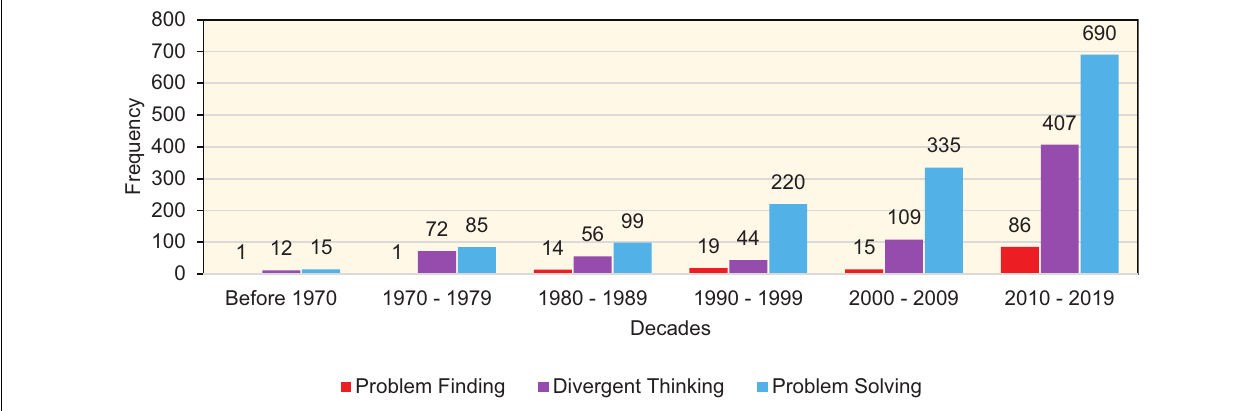
TABLE 1 | Selected studies focusing on the relationship between DT and PF.